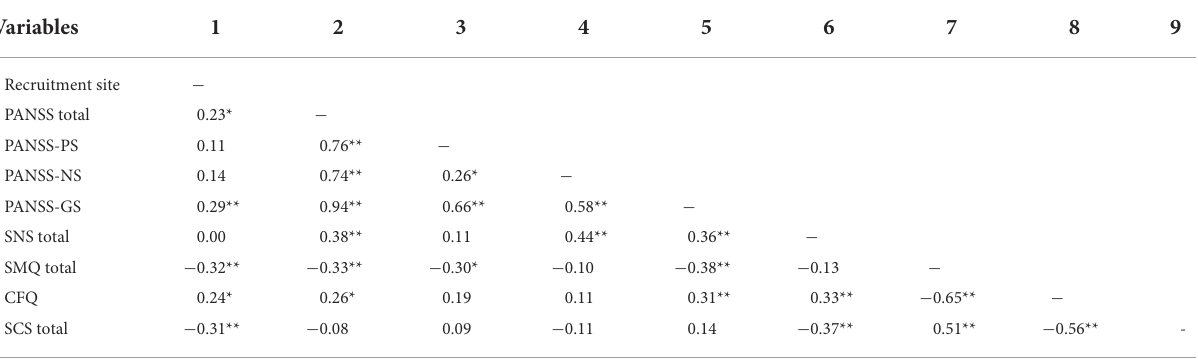
TABLE 3 Correlations.